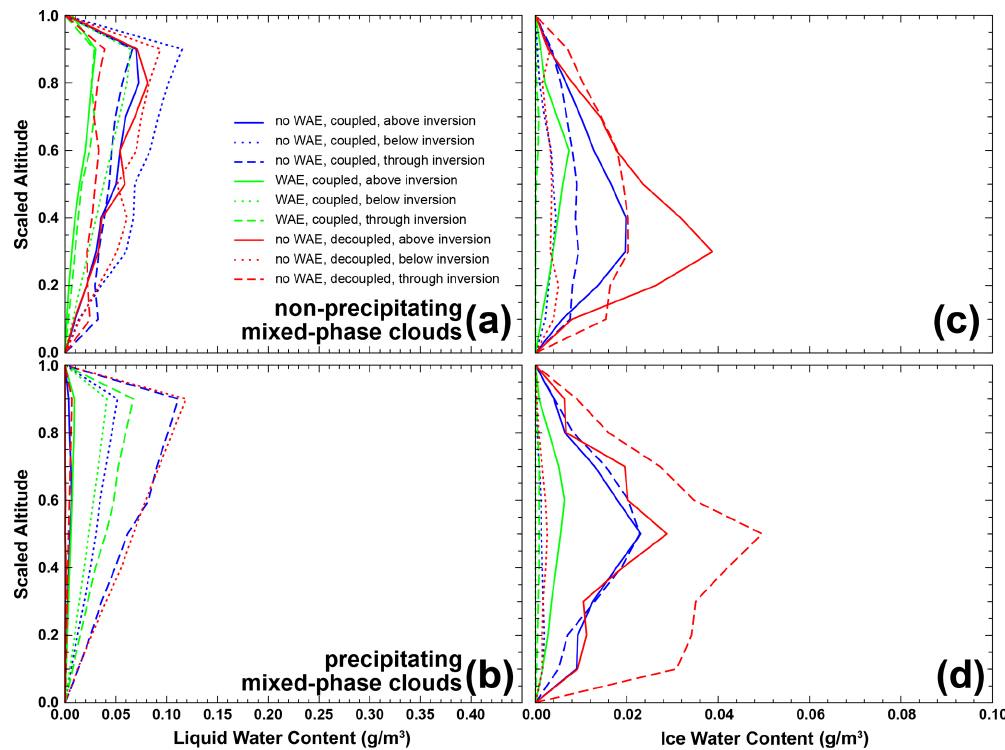
Figure 12. Scaled profiles of LWC (a, b) and IWC (c, d) for non-precipitating (a, c) and precipitating (b, d) mixed-phase clouds observed for different PBL structure, temperature at 1km height, and location with respect to the main inversion. Zero and unity of the scaled altitude refer to cloud base and top, respectively. Categories with fewer than 100 profiles have not been included.